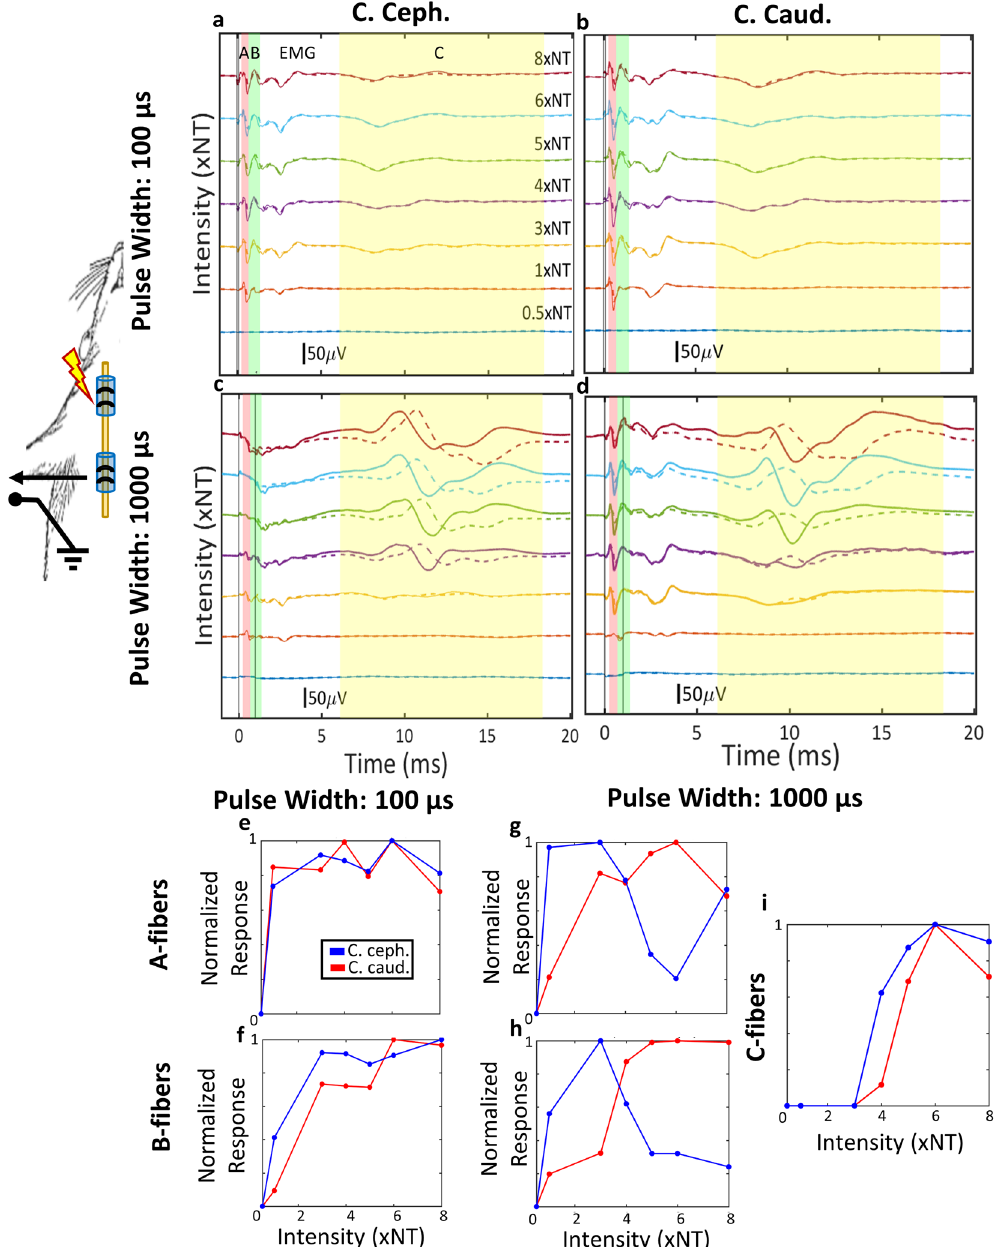
Figure 4. Example of the effect of stimulus polarity on A-, B- and C-fiber activation. In these experiments, VNS was delivered through a cuff placed rostrally on the cervical vagus, and stimulus-evoked compound nerve action potentials (sCNAPs) were recorded through a second cuff placed caudally (schematic diagram). ( a ) sCNAPs elicited by short pulse width (100 μ s) stimuli with cathode cephalad polarity, in order of increasing intensity from bottom to top. Stimulus intensity is expressed in units of neural threshold (NT): intensity of 1 corresponds to the minimum intensity eliciting a visible neural response. Vertical shaded areas denote latency windows associated with activation of different fiber types, as explained in Fig. 1. ( b ) sCNAPs elicited by short pulse width stimuli with cathode caudad polarity. ( c,d ) sCNAPs elicited by long pulse width (1000 μ s) stimuli with cathode cephalad polarity ( e ) and cathode caudad polarity ( f ), in order of increasing intensity from bottom to top. ( e,f ) Magnitude of A- and B-fiber activation, respectively, as a function of intensity of short pulse width stimuli, compiled from sCNAPs shown in panels (a,b). C-fibers were not activated at this pulse width, hence not reported here. ( g–i ) Magnitude of A-, B- and C-fiber activation, respectively, as a function of intensity of long pulse width stimuli (data from panels